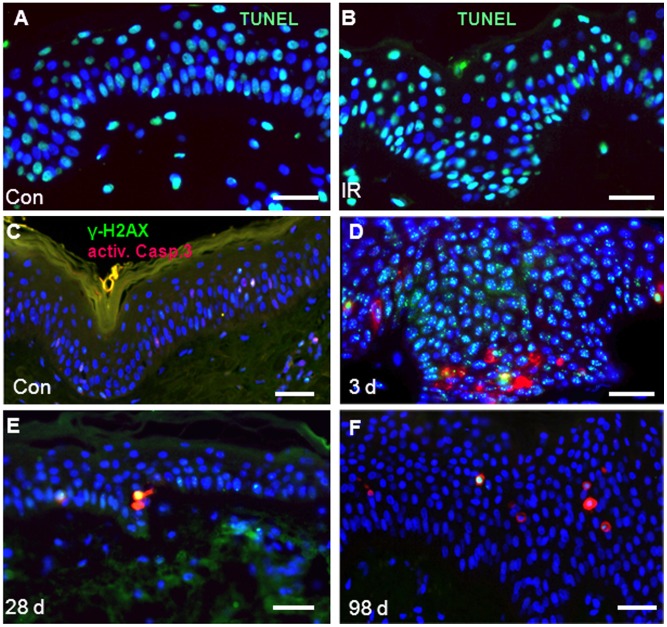
Acute IR exposure of the skin leads to caspase-dependent apoptosis.(A) TUNEL staining renders the epidermis largely positive for fragmented DNA in control (con) and (B) 50Gy-exposed skin sections (4 h post IR). (C-F) Immunofluorescence for activated-caspase 3 (a.casp.3; red) and γ-H2AX (green). Nuclei are counterstained with DAPI (blue). (C) Unirradiated control is largely lacking activated caspase 3-positive cells. (D) Three days post IR numerous activated-caspase 3-positive cells are present in the basal layer of the epidermis. (E) At 28 days post IR only few cells are positive for activated caspase 3. (F) 98 days post IR activated-caspase 3-positive cells often occur in the spinous layer of the epidermis (nuclei, blue) relative to the earlier time points. Activated-caspase 3-positive apoptotic cells at late time points often are also strongly positive for γ-H2AX nuclear staining (green; yellow due to signal overlap). Magnification bar: 20 µm.